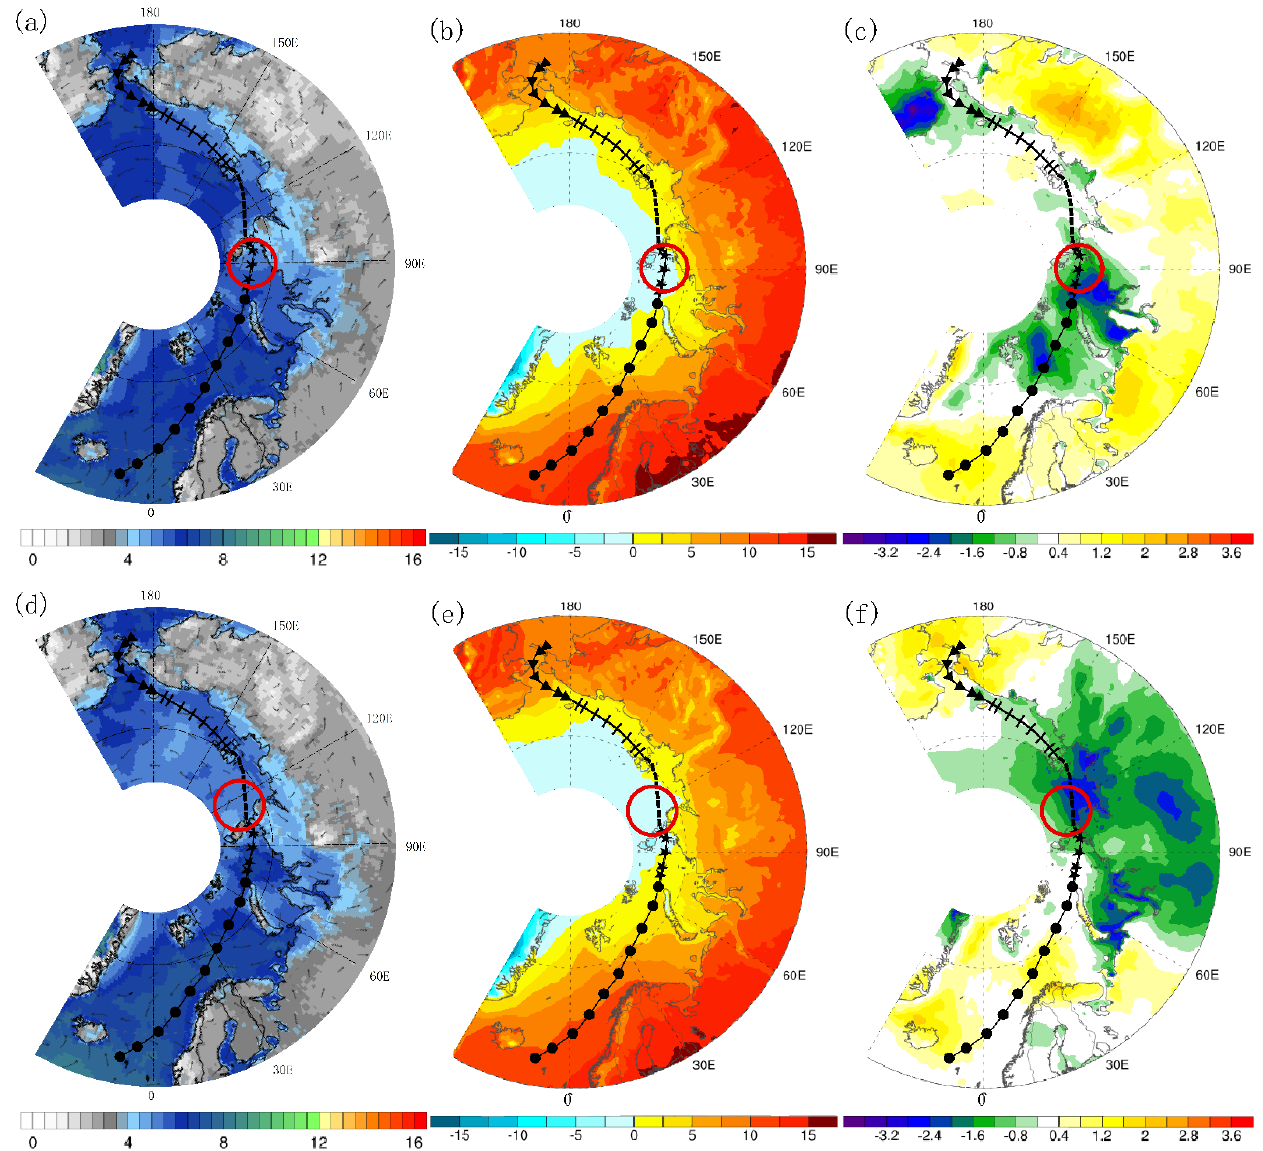
Figure 9. The average wind field ( a ), average temperature ( b ) and temperature anomalies ( c ) of the NEP in the Arctic summer (July–September) in 2003. The average wind field ( d ), average temperature ( e ), and temperature anomalies ( f ) of the NEP in the Arctic summer in 2004.